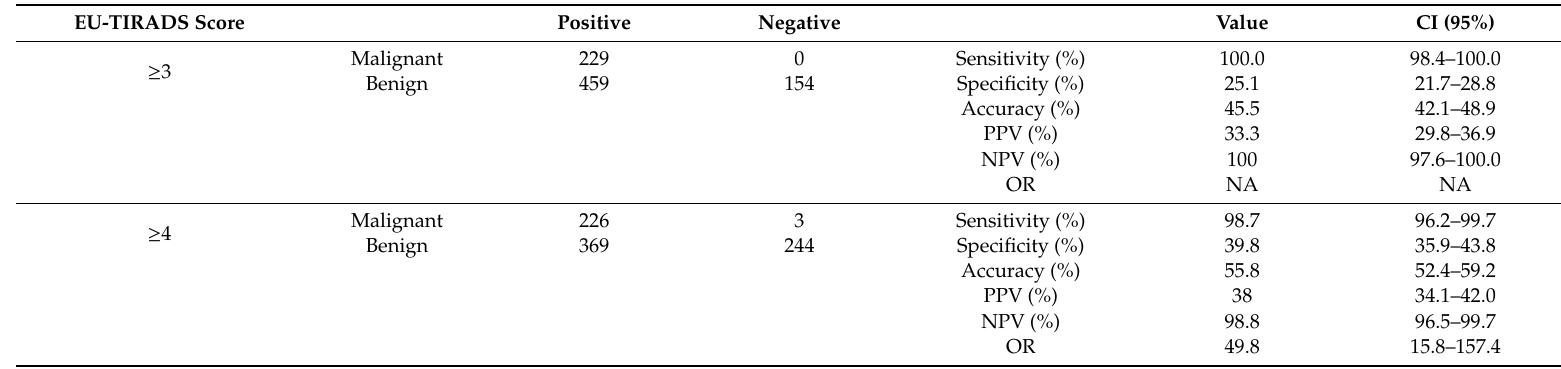
Table 4. Statistical analysis discriminating accuracy of malignant and benign thyroid nodule diagnosis when assigning the EU-TIRADS category cut-o ff (PPV—positive predictive value, NPV—negative predictive value, OR—odds ratio). Not applicable (NA) is presented to avoid dividing by